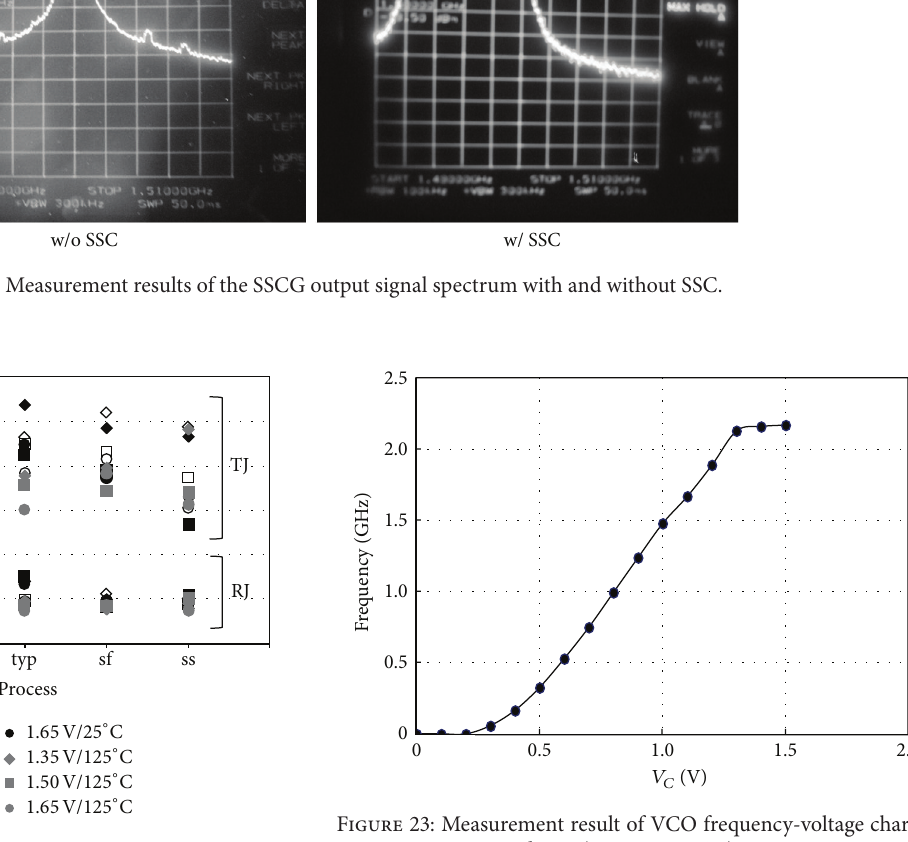
Figure 23: Measurement result of VCO frequency-voltage charac- teristics in worst condition (SS/1.35V/125 ∘ C).